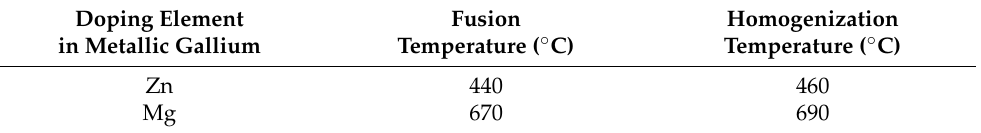
Table 1. Fusion temperature, and homogenization temperature of the doping elements. Doping